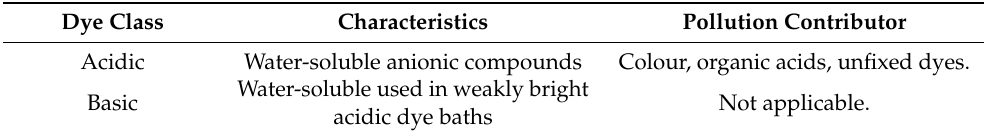
Table 1. Characteristics and category of common industrial dyes